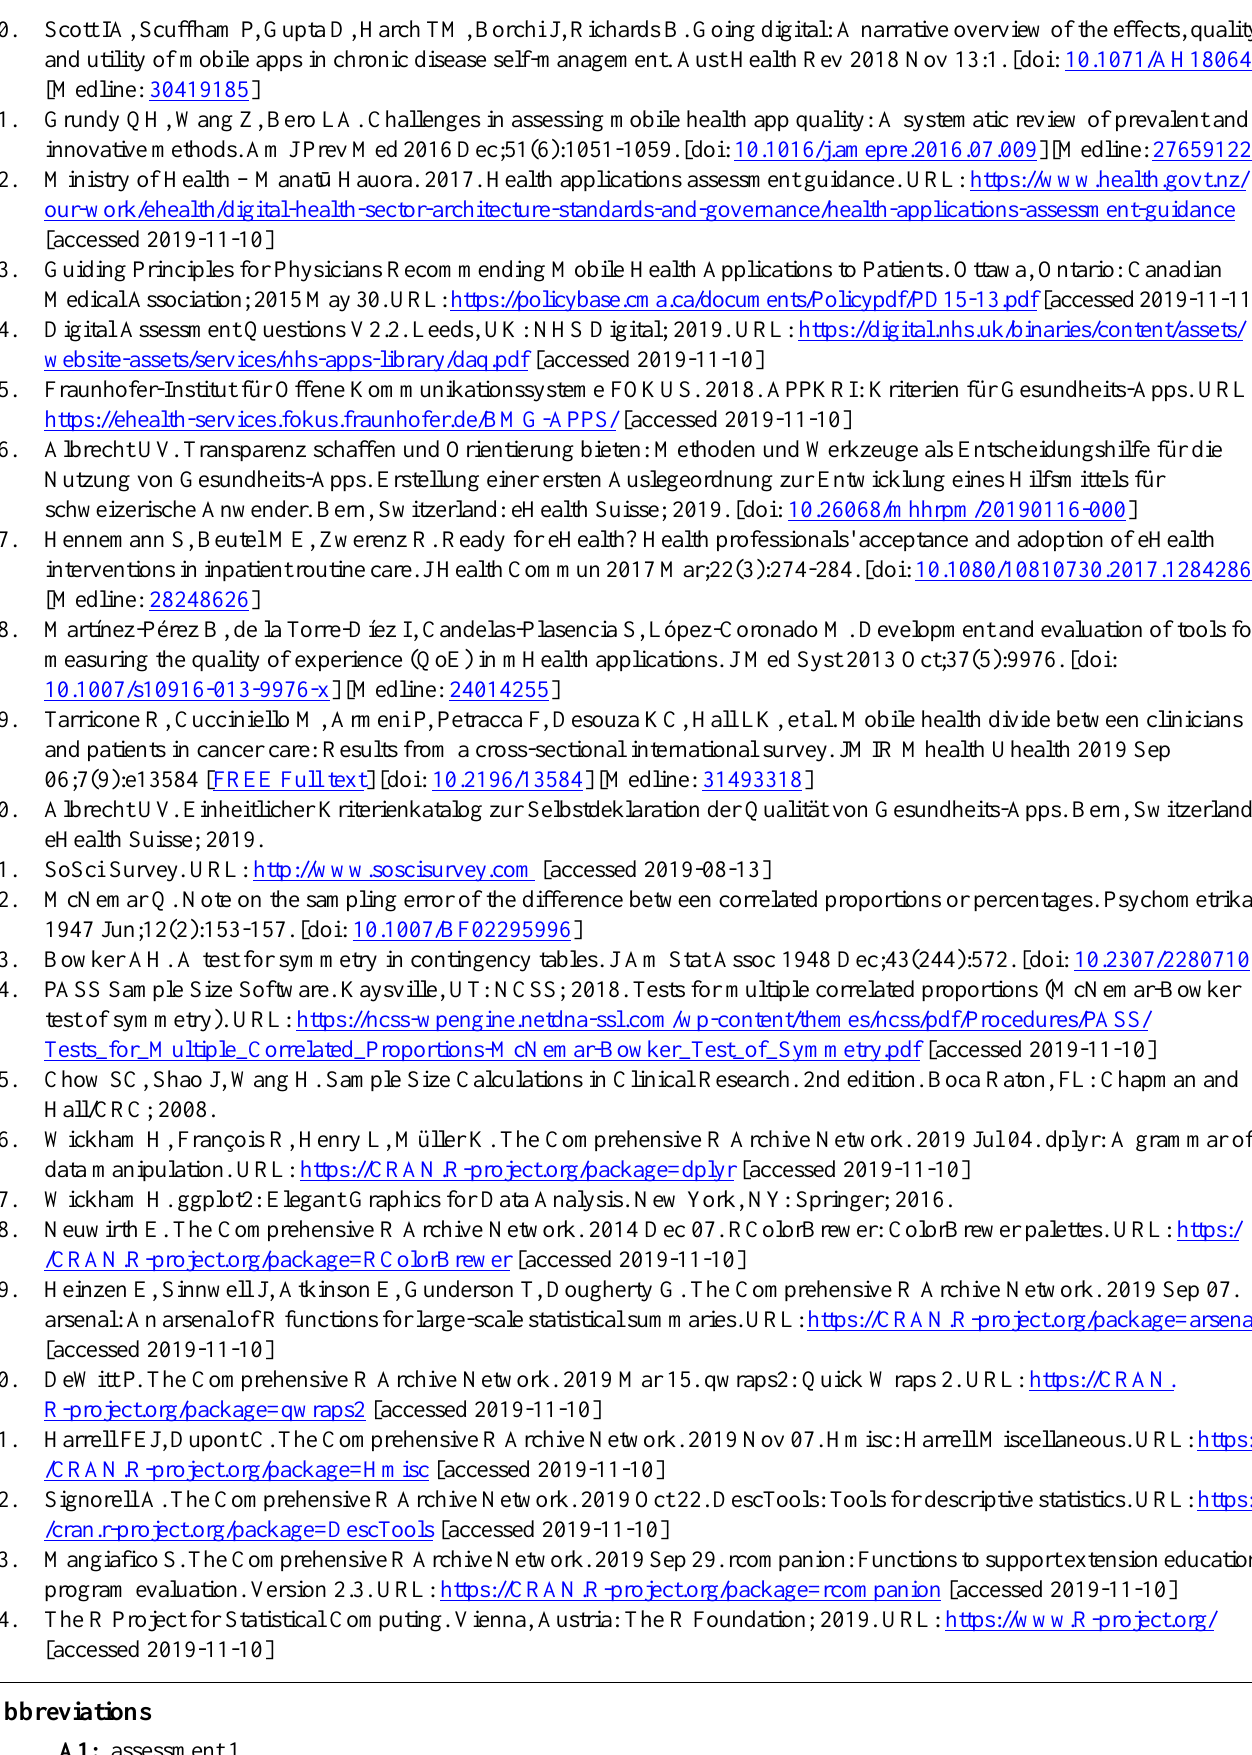
Abbreviations A1: assessment